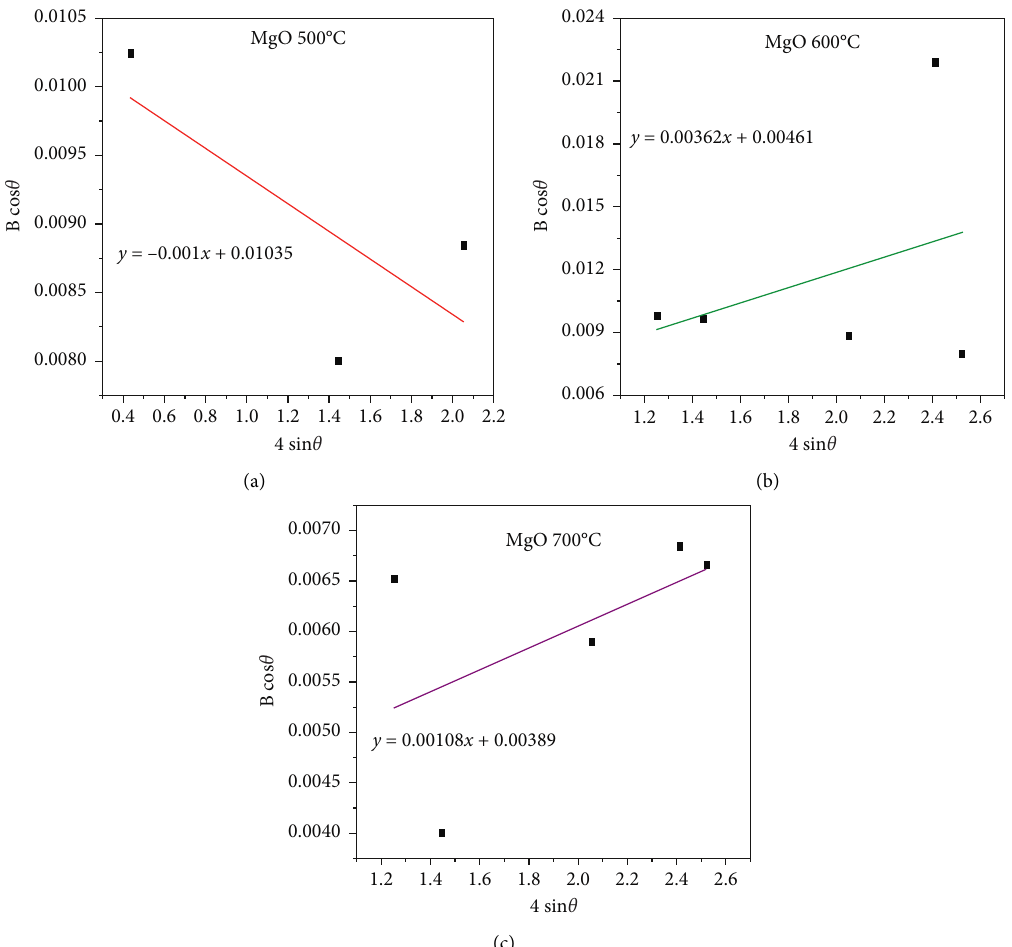
Figure 5: William–Hall plot of MgO nanoparticles at 500 ° C, 600 ° C, and 700 ° C (a, b, and c). Table 1: Calculated crystallite size and lattice parameters, dislocation density, and lattice strain.